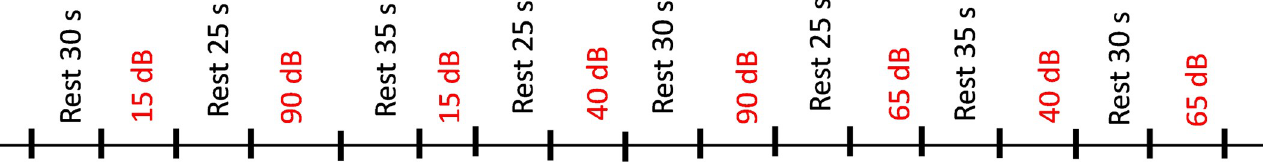
Fig 1. Block design of fNIRS experiment. Stimuli and rest times in an example test period are shown. Eighteen-second duration stimuli were presented twice at each level in counterbalanced order. Rest periods were 25, 30 or 35 seconds (chosen at random). One recording session consisted of 5 test periods with breaks of 2–3 minutes in